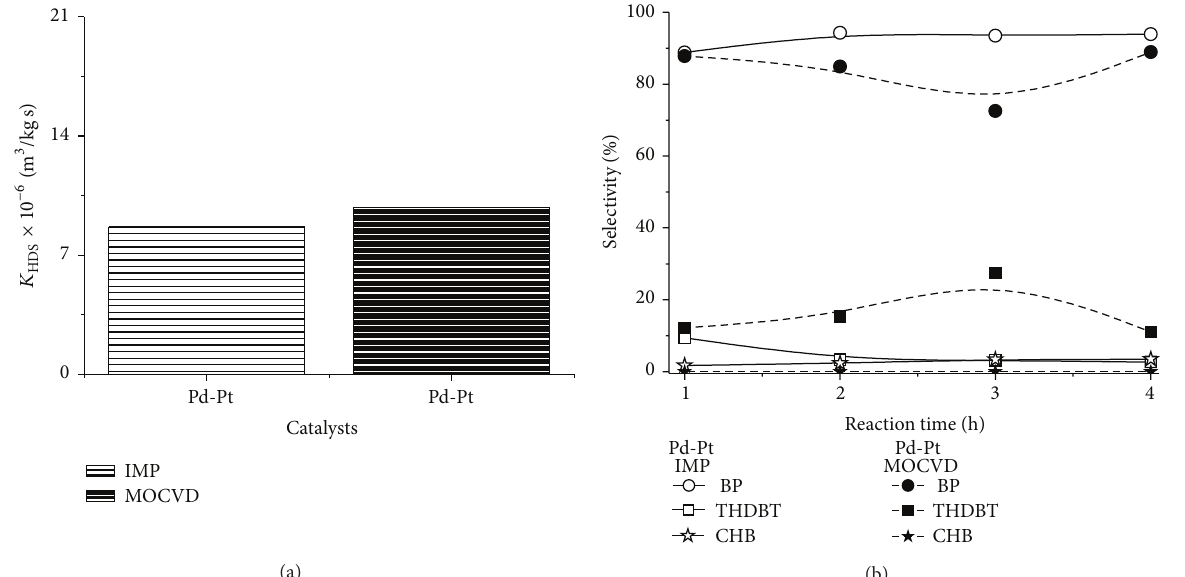
Figure 8: (a) Pseudo-first-order HDS intrinsic kinetic constants and (b) profile of HDS selectivity over bimetallic Pd-Pt catalysts evaluated in the HDS of DBT ( 𝑃 = 5.59 MPa, 𝑇 = 350 ∘ C).